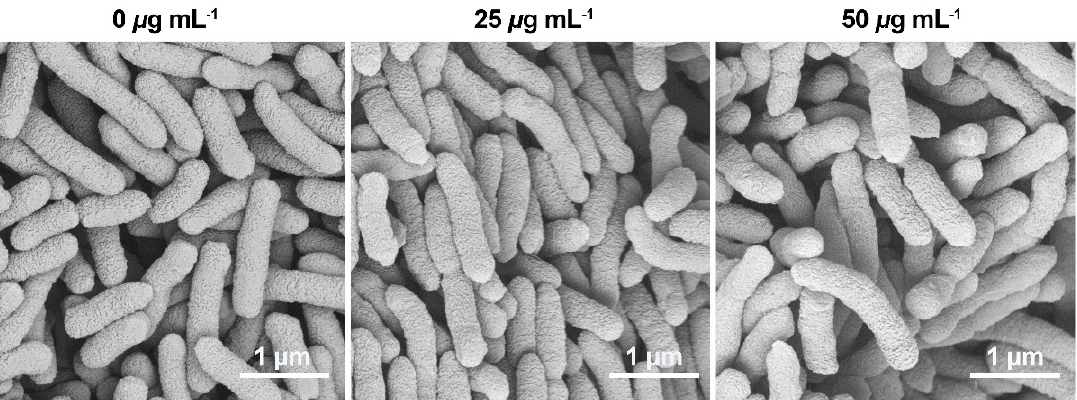
Figure 8. Scanning electron microscope images of the morphology of the Xanthomonas oryzae pv. oryzae cell membrane induced by compound 2b at doses 0 (served as blank), 25, and 50 μ g mL − 1 24 h. Scale bars = 1 μ m.